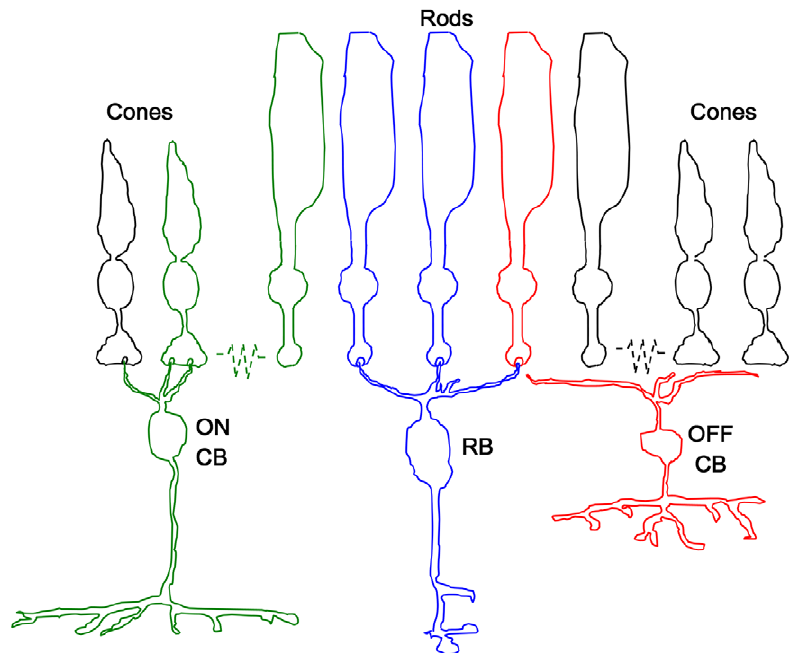
Figure 1. Schematic diagram of retinal rod pathways. The primary rod pathway (in blue) is from rods R rod bipolar cells. The second rod pathway (in green) is from rods R cones (through gap junctions) R ON and OFF cone bipolar cells. The third rod pathway (in red) is a direct connection between rods and OFF bipolar cells.